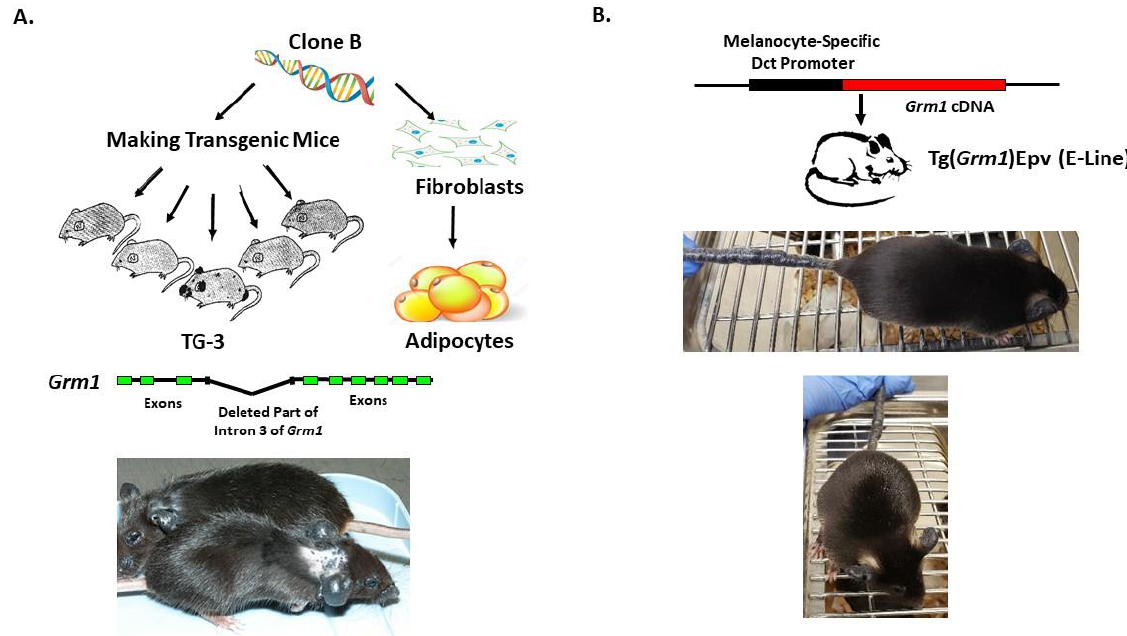
Figure 2. ( A ) Derivation of TG-3 and ( B ) Tg( Grm1 )Epv Spontaneous Grm1 Expressing Melanoma Prone Mouse Models.